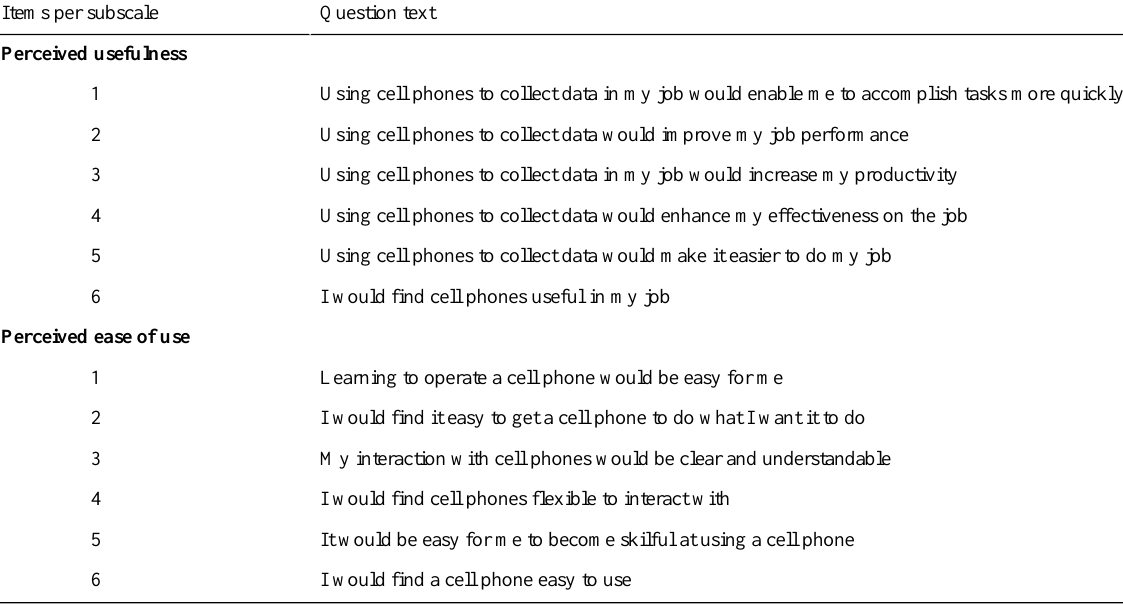
Table 1. Technology Acceptance Model